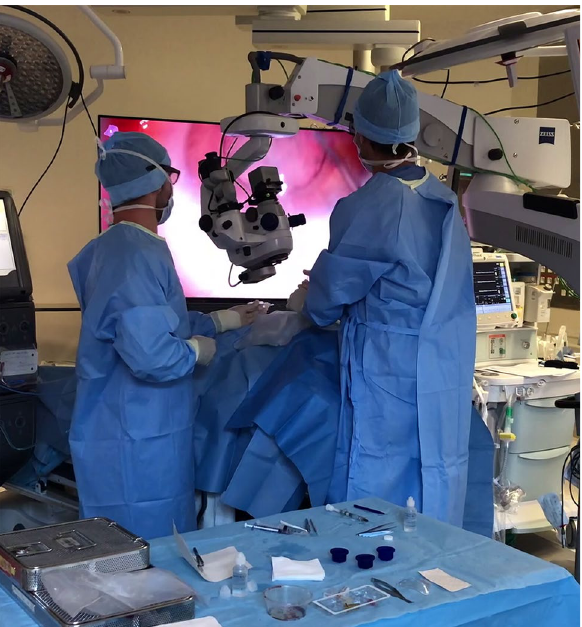
Figure 2. Use of the heads-up NGENUITY 3D Visualization System with a patient in semi-sitting position in our center. Patients who can only be operated on in a semi-sitting position can be operated on by the surgeon